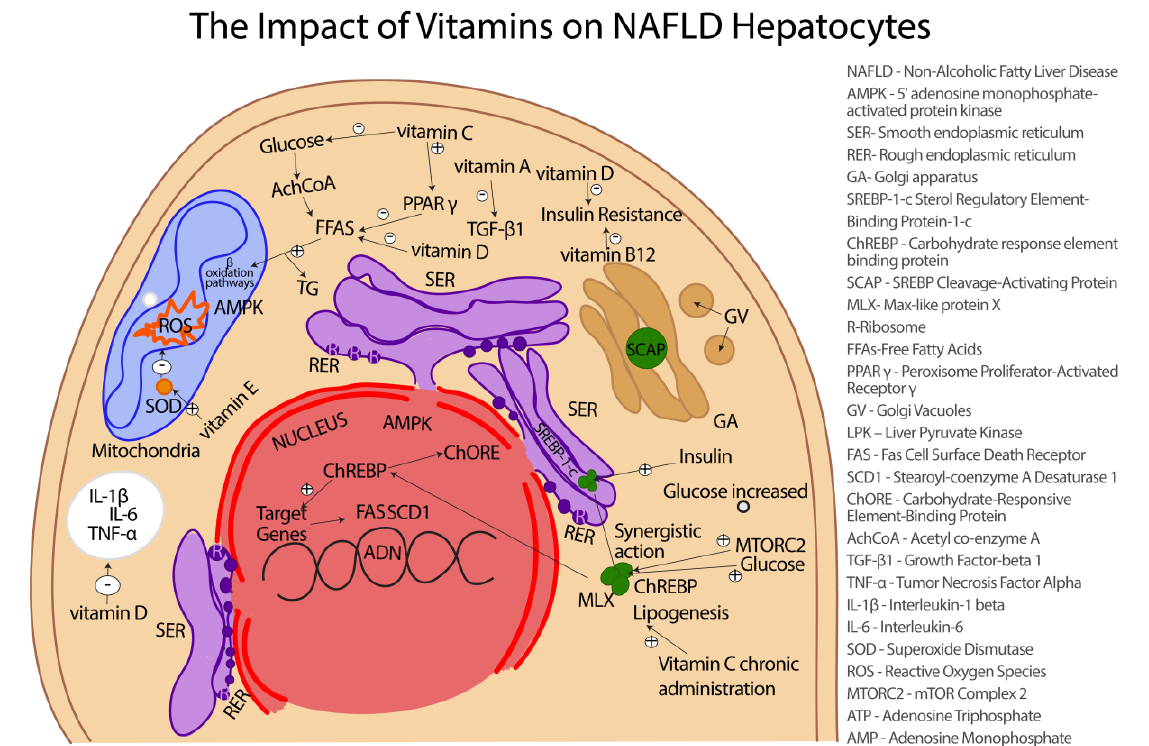
Figure 2. The impact of vitamins on hepatocytes affected by NAFLD.